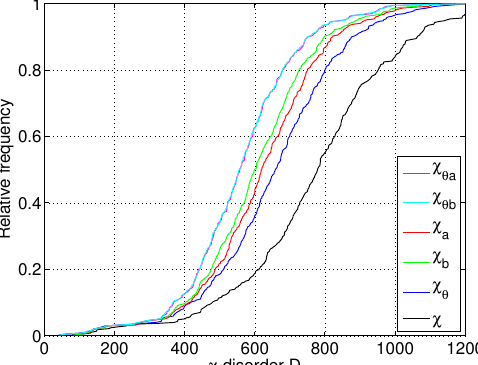
Figure 8. Cumulative distribution of the χ disorder for the 371 considered catchments in the European Alps for 0 . 01 km 2 ≤ A ≤ 100 km 2 . Each curve describes the relative number of the catch- ments with a χ disorder lower than or equal to the value D on the x axis.